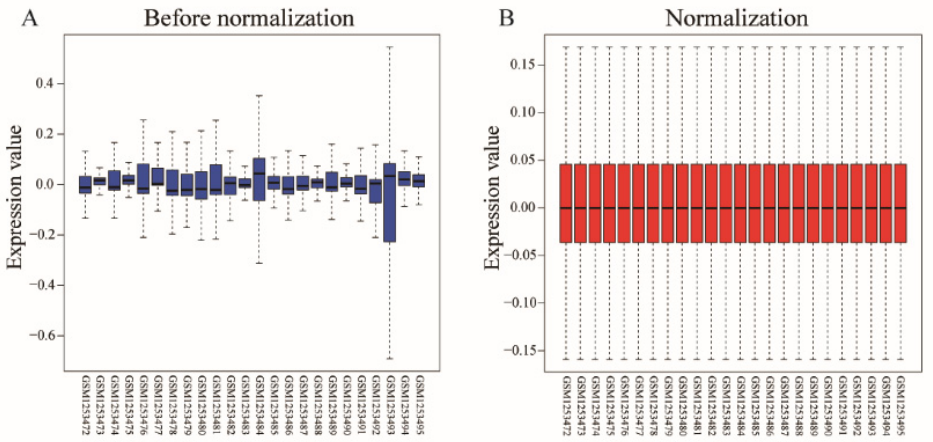
Figure 1. Normalization of gene expression in the GSE51835 dataset.